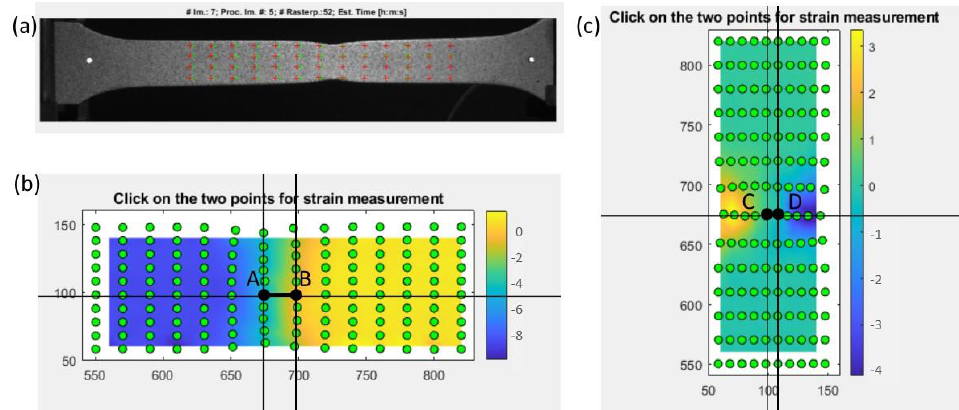
Figure 13. Characteristics of the DIC measurement: ( a ) final stage of tension, ( b ) true strain measurement in the longitudinal direction (distance AB), ( c ) true strain measurement in the latitudinal direction (distance CD).